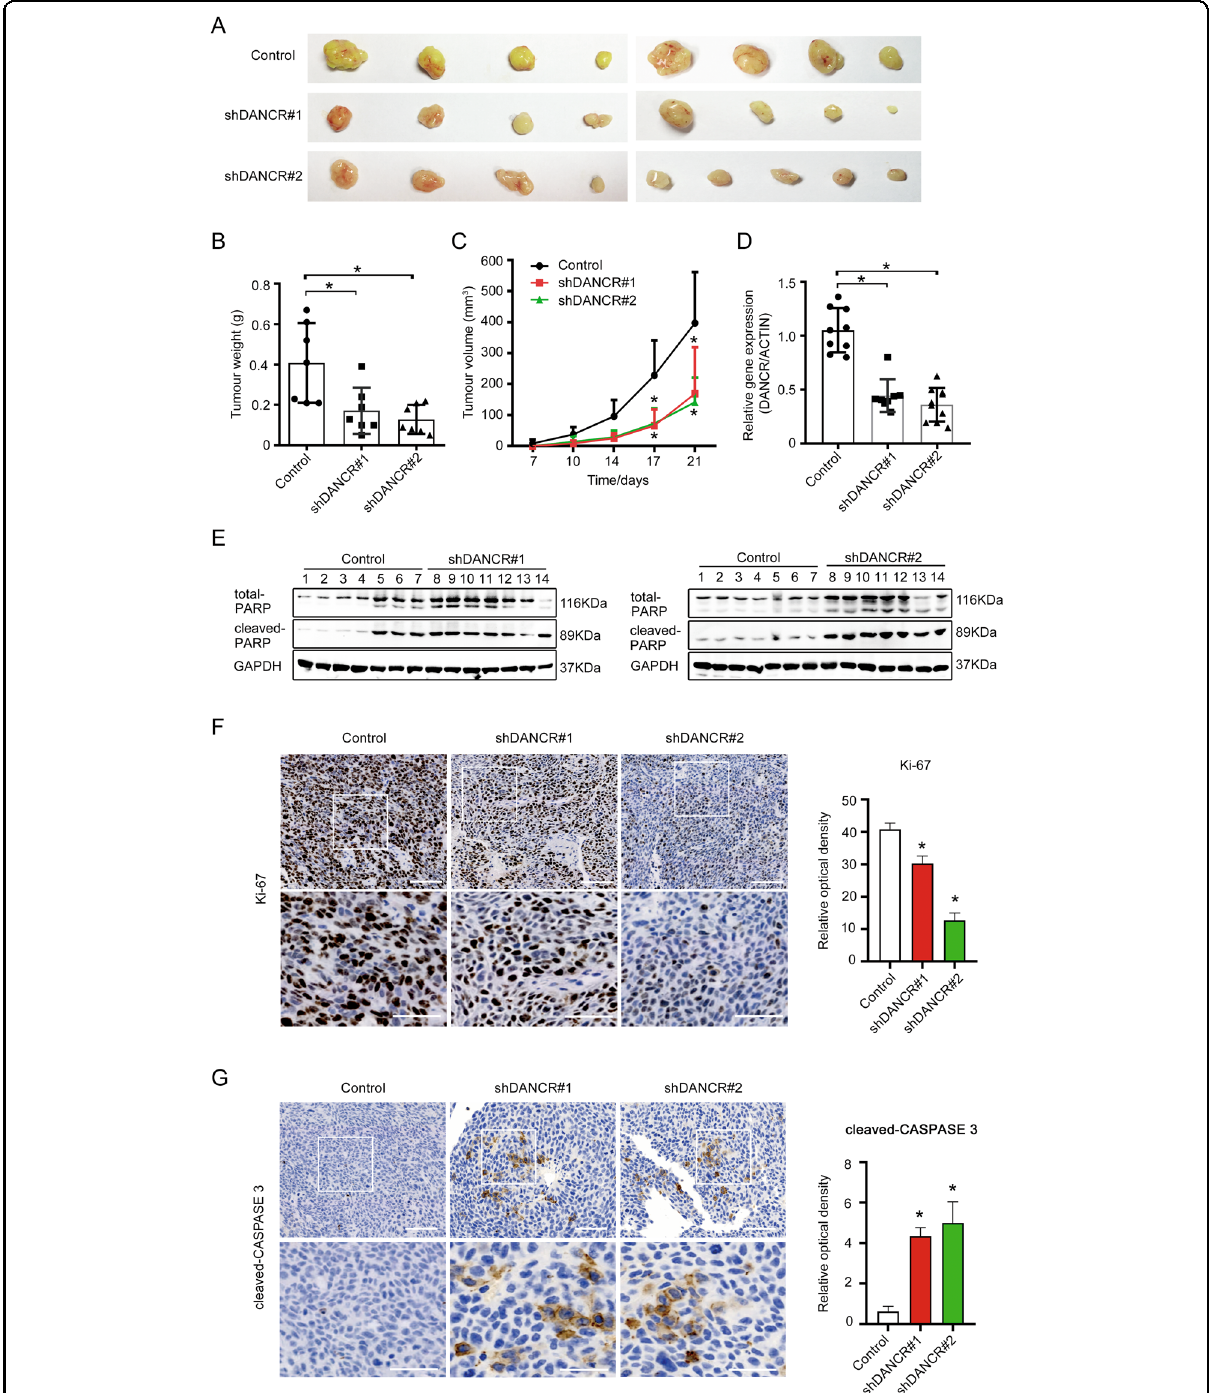
Fig. 3 DANCR suppressed apoptosis of colorectal cancer cells in vivo. A Morphology of xenograft tumors formed by HCT116 cells with DANCR shRNAs or control cells. B , C Comparison of the weight and the size of xenograft tumors as shown in A . * p < 0.05. D The expression of DANCR in xenograft tumors as shown in A was analyzed by qRT-PCR. * p < 0.05. E The expression of cleaved PARP in xenograft tumors was detected by Western blotting. F , G The expression of Ki-67 and cleaved CASPASE 3 in xenograft tumors was showed in representative immunohistochemical images (left). Relative optical density of the expression of Ki-67 and cleaved CASPASE 3 was analyzed (right). Bar, 100 μ m (upper panel) and 50 μ m (lower panel). * p <